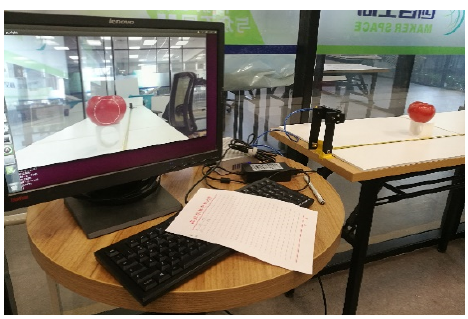
Figure 19. Experimental environment I.